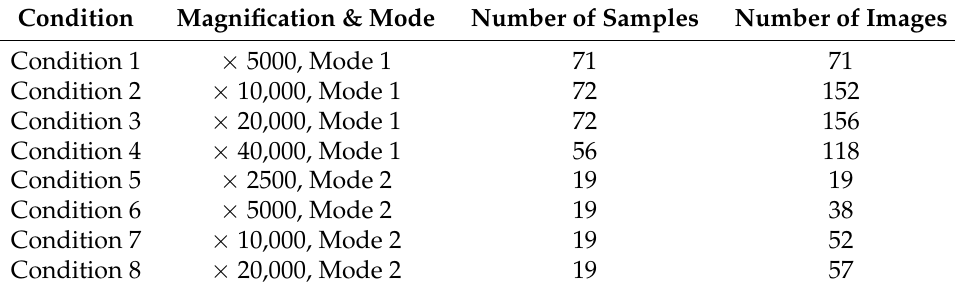
Table 1. Numbers of samples and electron microscope images in each